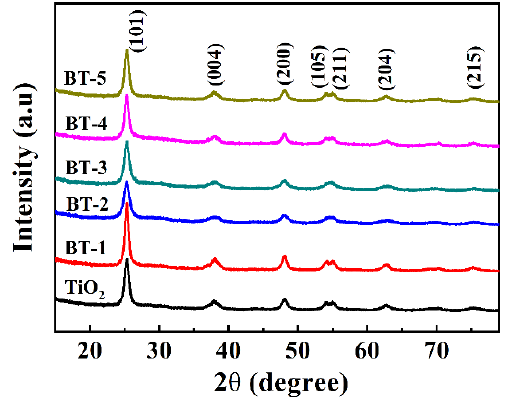
Figure 3. XRD patterns of as-prepared samples.